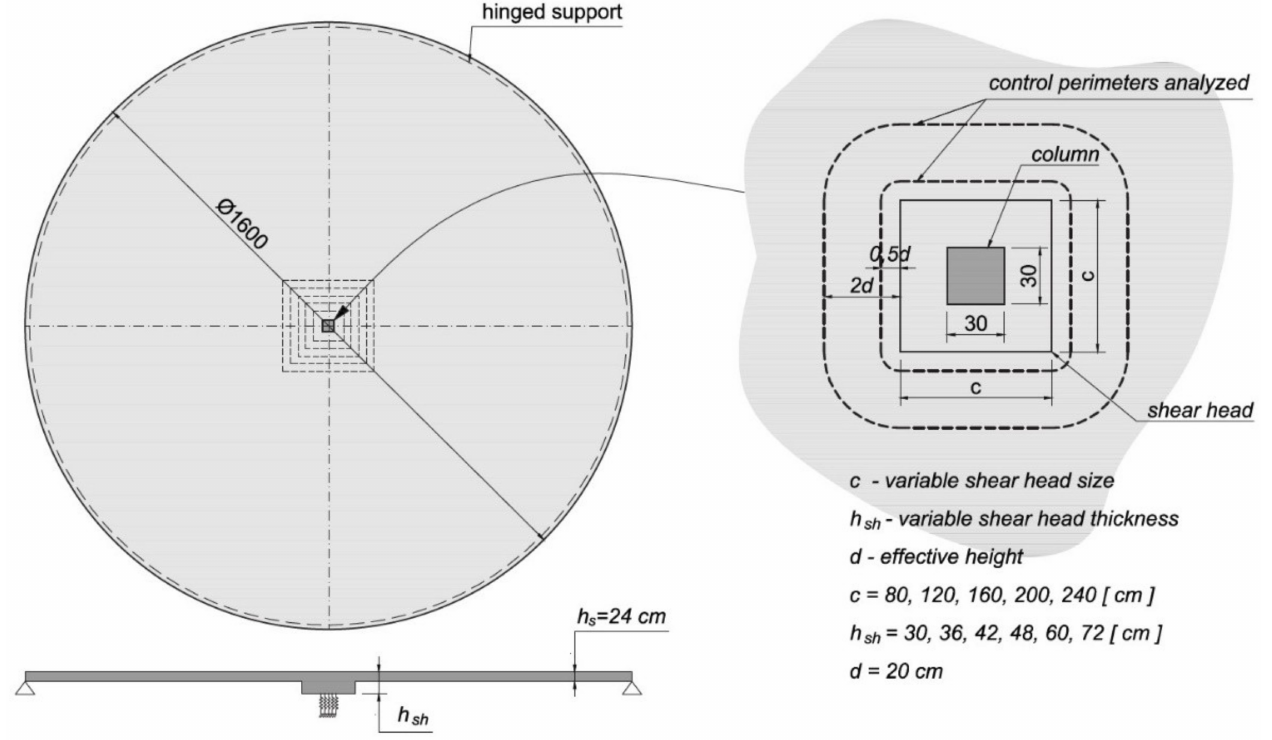
Figure 7. The geometry of the analyzed structural system—the influence of the dimensions and height of the shear cap.